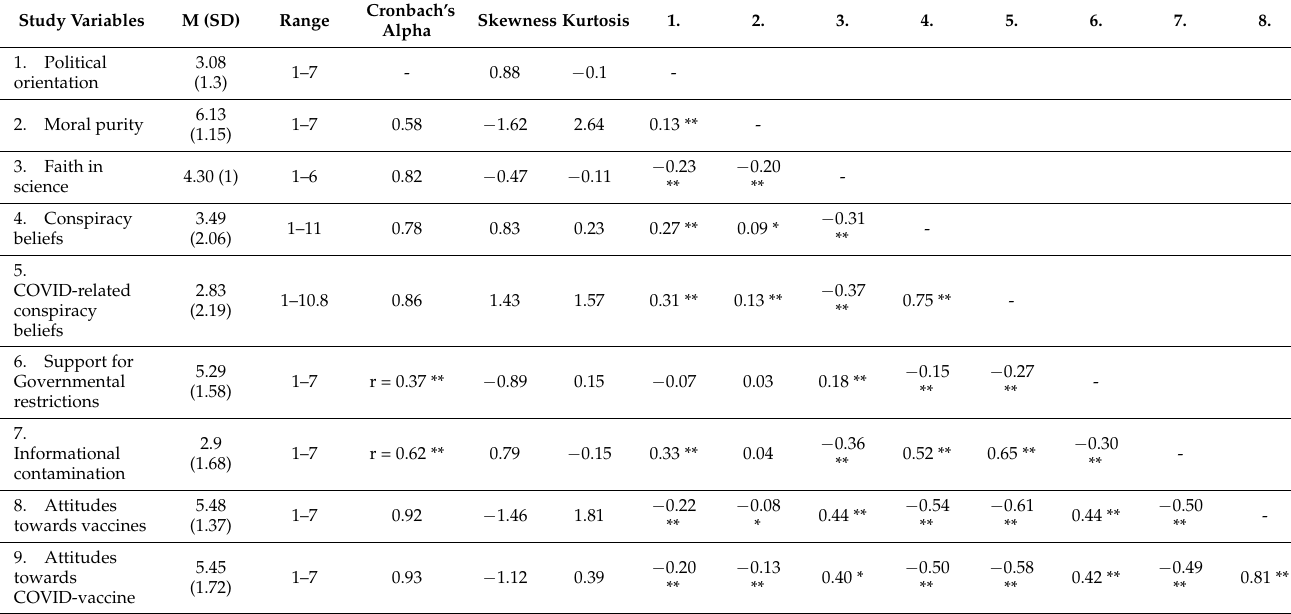
Table 1. Descriptives and Pearson’s correlations among the